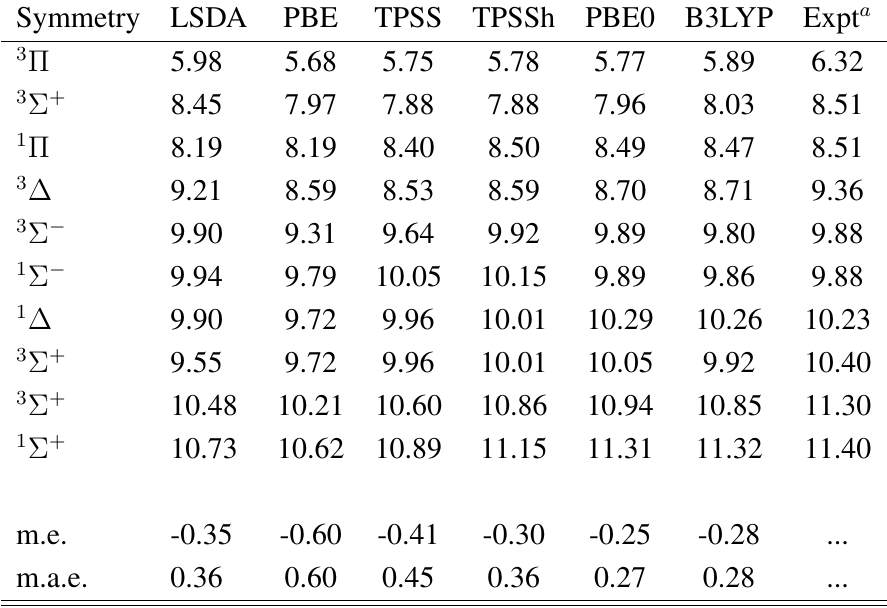
Table 2. Low-lying excitation energies (in eV) of CO calculated using six functionals with the basis set 6-311++G(3df,3pd). Calculations are performed using the geometry optimized on respective functionals with the same basis. The mean error (m.e) and the mean absolute error (m.a.e.) are also shown. The mean experimental value is 9.58